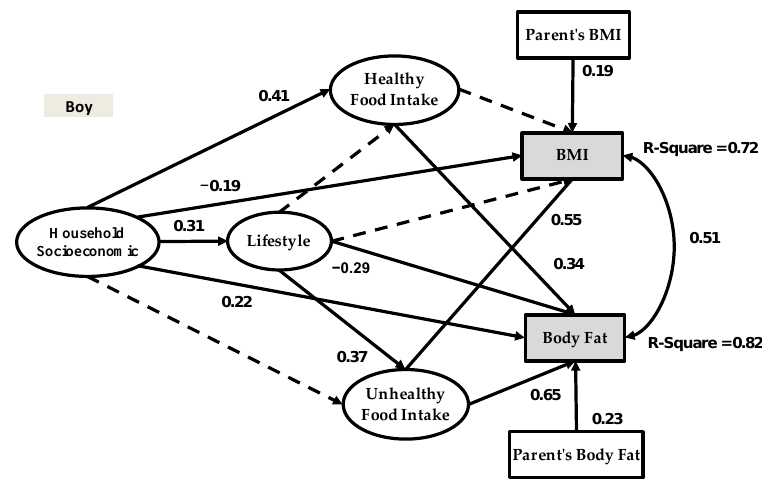
Figure 4. Adolescent boy obesity model.